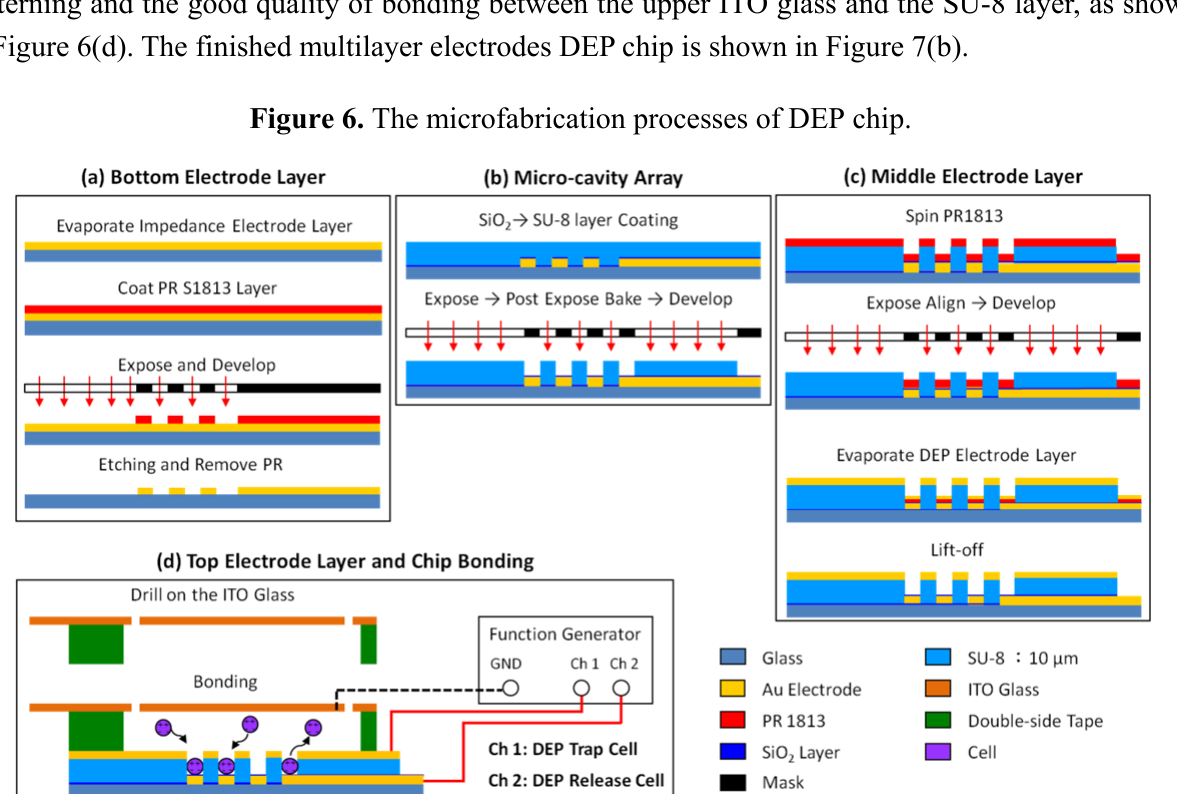
Figure 7. (a) the SEM image of the 3 × 3 micro-cavity array; (b) the photograph